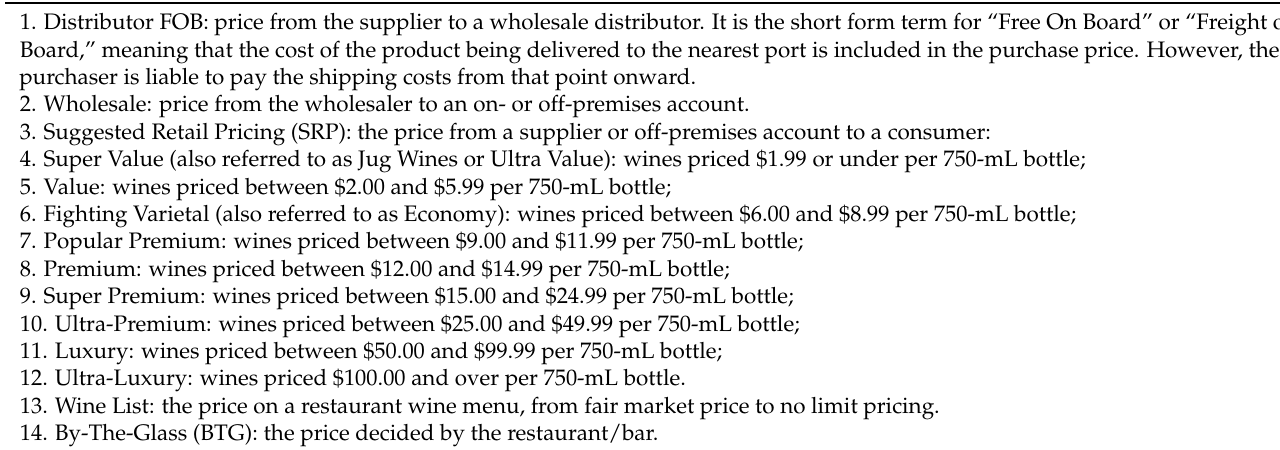
Table 1. Pricing terminology and price range used in the wine value